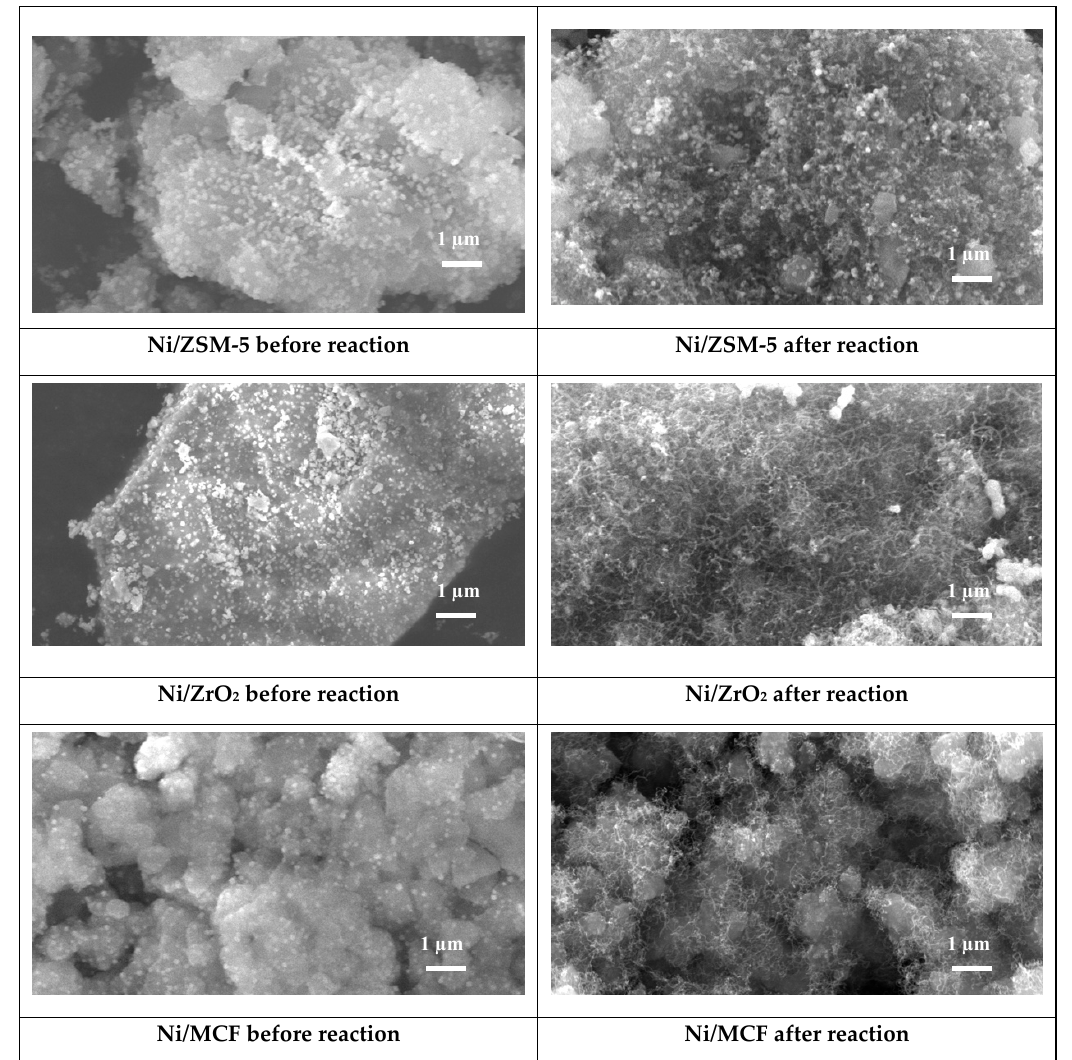
Figure 5. Scanning electron microscopy (SEM) images of the catalyst before and after cellulose decomposition process (magnification 10,000×).